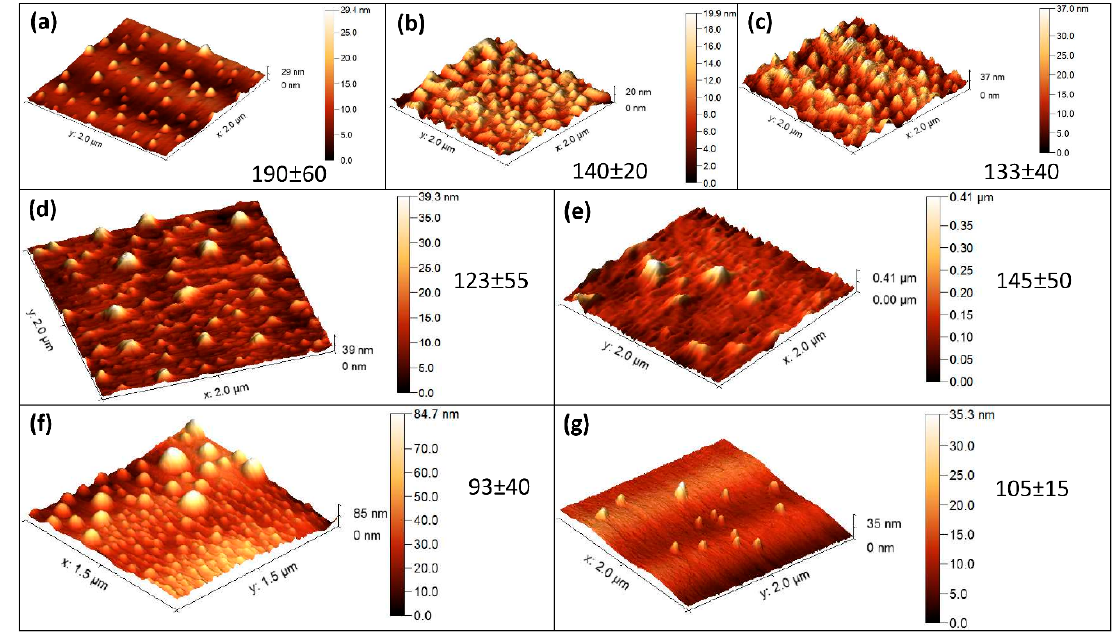
Figure 6. AFM images of AKX-371-5 polymer ( a ), complexes of polymers AKX-371-5 ( b , c ), AKX-371-2 ( d , e ) and AKX-371-3 ( f , g ) with single strand ( b , d , f ) and double strand ( c , e , g ) 20-mer DNA. N/P ratios are 180 ( b , c ), 150 ( d , e ) and 155 ( f , g ). AKX-371-1 did not give particles appropriate for AFM study. Numbers near pictures present average sizes of the particles, nm.